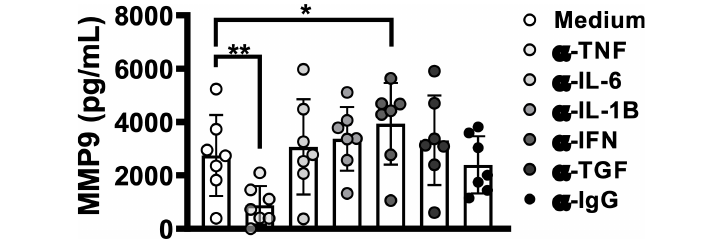
FIGURE 4 TNF blockade decreases MMP-9 levels in HTLV-1 infection . PBMCs from HTLV-1-infected individuals, including those with or without OAB or HAM/TSP, were cultured for 72 hours in the presence or absence of the following monoclonal antibodies: anti-TNF, -IFN- g , -IL-1- b , -IL-6 and -TGF- b . MMP-9 levels were assessed in culture supernatants by ELISA. Bars represent median values from each group. Nonparametric testing (Mann-Whitney) was used to compare among groups. *P < 0.05, **P < 0.005.